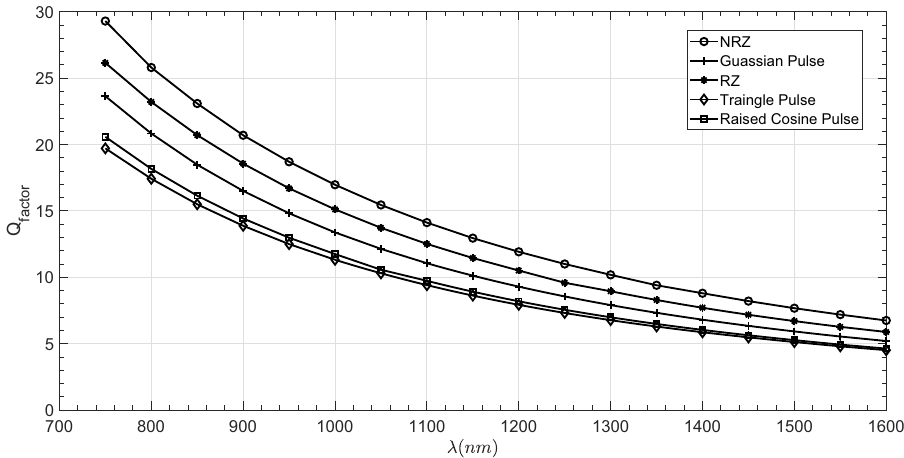
Figure 5: Quality factor ( Q factor ) as a function of the transmitted laser wavelength ( λ nm ( ) ) for di ff erent optical modulation schemes W/zero pointing